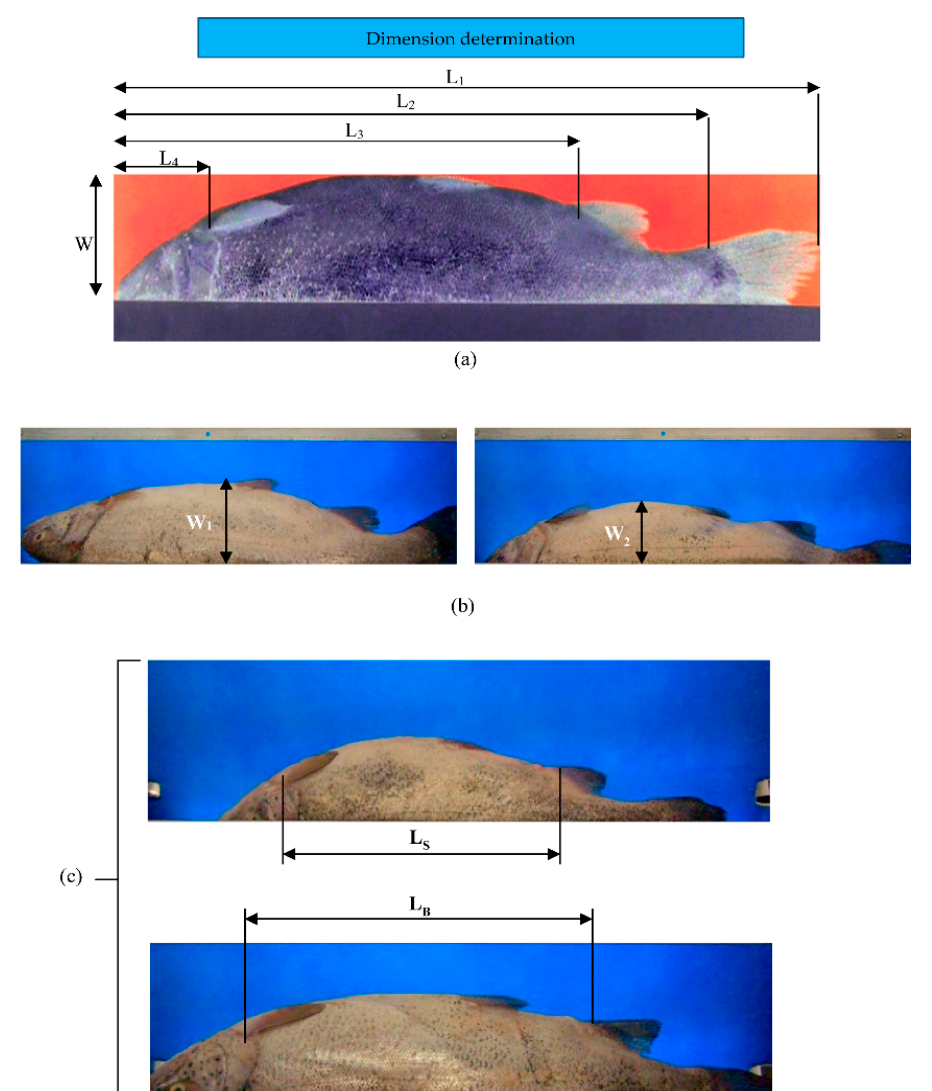
Figure 2. Trout fish dimensions: ( a ) determining trout dimensions (L 1 to L 4 are head-cutting point, belly-cutting start point, trout length without the tail, and the total length, respectively and W is the fish width), ( b ) comparing the width in different fish samples (W 1 and W 2 are different trout width), and ( c ) comparing the functioning length of actuating arms in two fish samples with different lengths (L S and L B are functioning length for small and big fish).